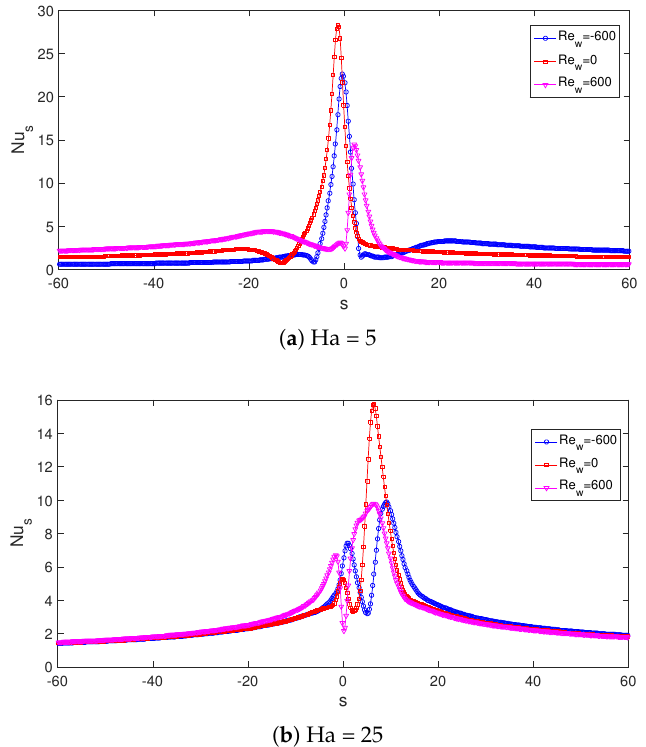
Figure 6. Local Nu variations with changes in Rew at two MaF strength levels (Da = 5 × 10 − 2 , Mx = − 1, AR = 0.5).